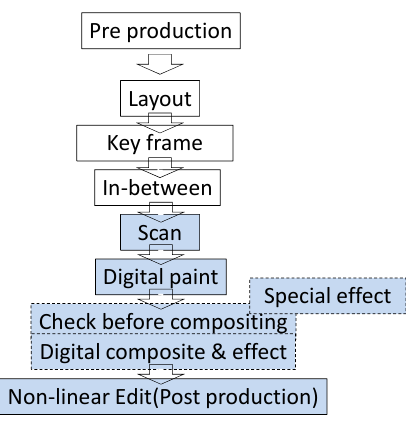
Figure 2. Main production